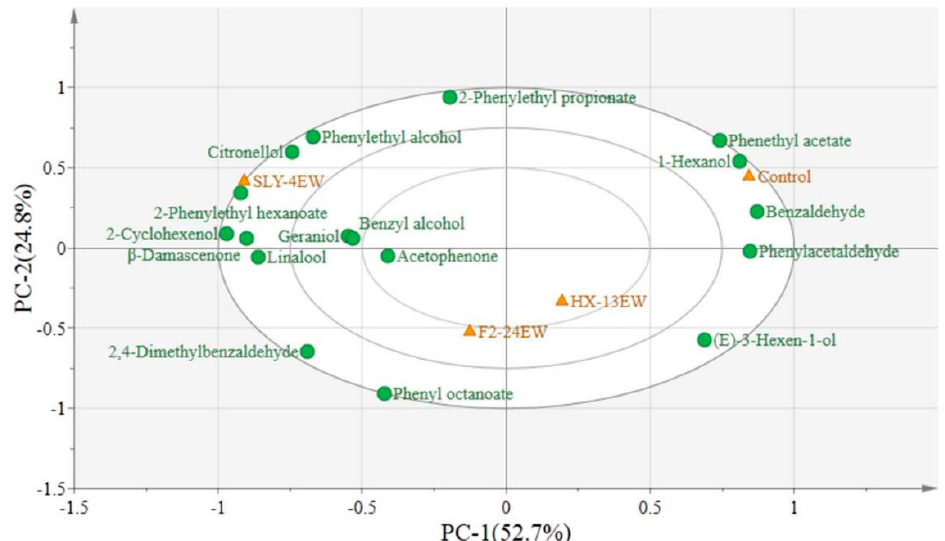
Figure 2. Bioplot of PCA for varietal aroma compounds from wines treated by crude β - glucosidase from different non- Saccharomyces yeasts. SLY-4EW: Wines treated by crude β - glucosidase from I. terricola SLY-4; F2-24EW: Wines treated by crude β -glucosidase from P. kudriavzevii F2-24; HX-13EW: Wines treated by β - glucosidase from M. pulcherrima HX-13; Control: Wines without enzyme treatment.: ::Wine samples; :Varietal aroma compounds.